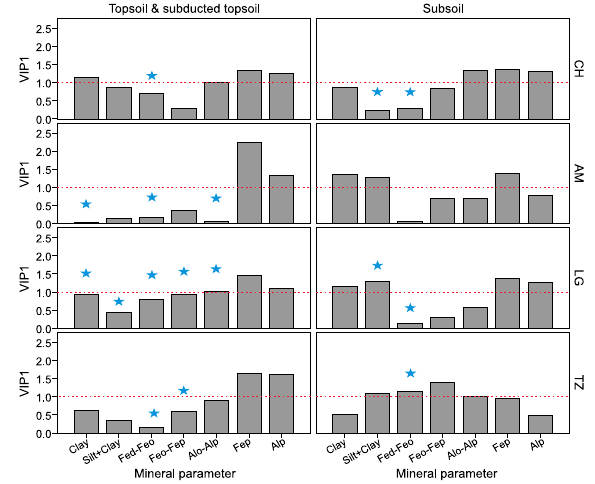
Figure 7. The influence of the PLSR predictor variables on HF- OC concentrations plotted as variable importance in the projection (VIP; see Sect. S2) for the first latent factor (see Table 3). Parame- ters representing the soil mineral phase were used as response vari- ables. Values above the dashed line indicate an above average in- fluence on the response variable. The stars denote negative loadings on a given